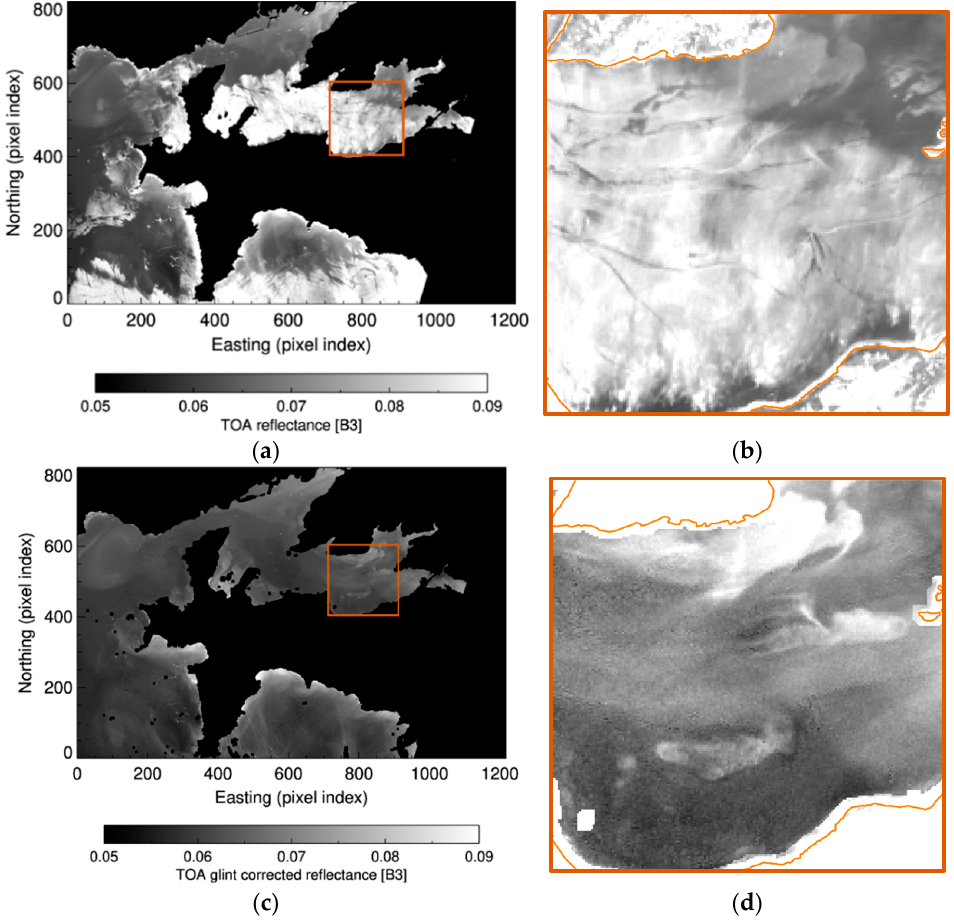
Figure 7. TOA reflectance in OLI channel B3 for sample scene BRS-3 before ( a ) and after ( c ) glint correction; ( b ) Enlarged detail covering an area of 6 × 6 km² before correction at identical reflectance grey scale [0.05–0.09]; ( d ) Enlarged detail after correction using an optimized grey scale [0.055–0.07]. See text for further explanation.